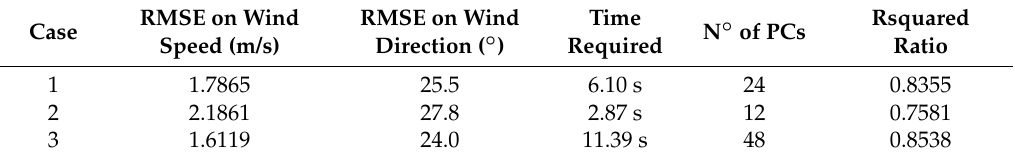
Table 2. Performance Indexes using PLSR.